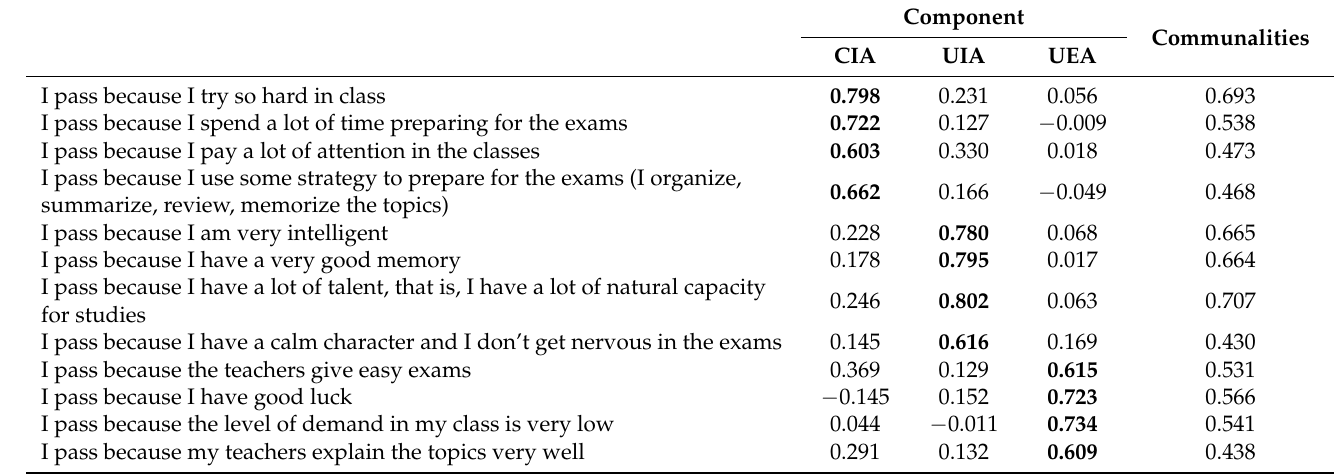
Table 1. Exploratory factor analysis of the “Academic Success Attribution Scale”.